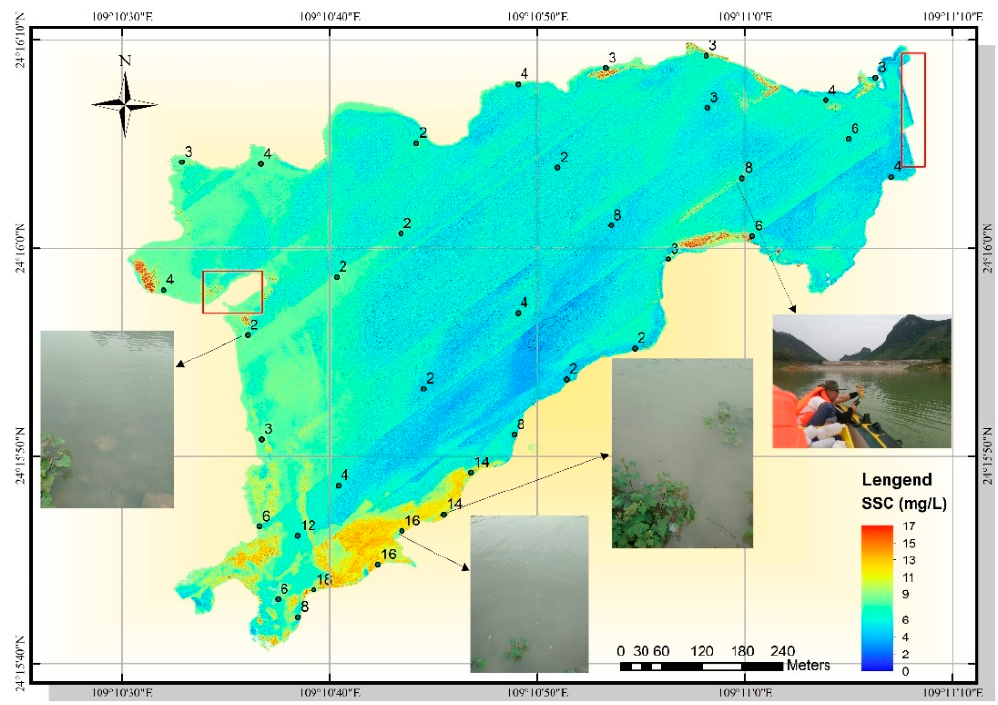
Figure 13. Inversion results of SSC for the UAV-borne HRS images for the BR dataset.